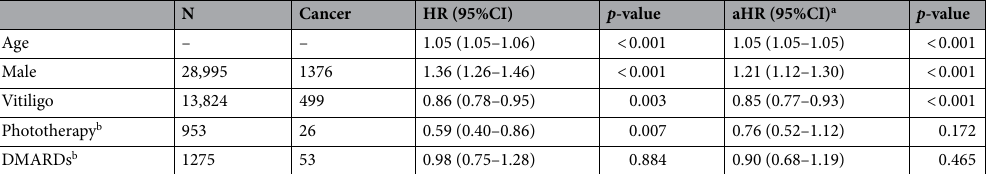
Table 3. Multivariate analysis of predicting factors for cancers among study cohorts. aHR adjusted hazard ratio, DMARDs disease modifying antirheumatic drugs, HR hazard ratio, N case number. a Adjustment for age, gender, study groups, hospital visit number, long term exposure of phototherapy and use of DMARDs, and major comorbidities including cardiovascular diseases, chronic liver disease, chronic renal diseases, and autoimmune diseases. b Indicates receiving long term ultraviolet B or ultraviolet A phototherapy for more than 100 sessions during the observation time. Use of DMARDs for more than 30 days per year on average during the observation